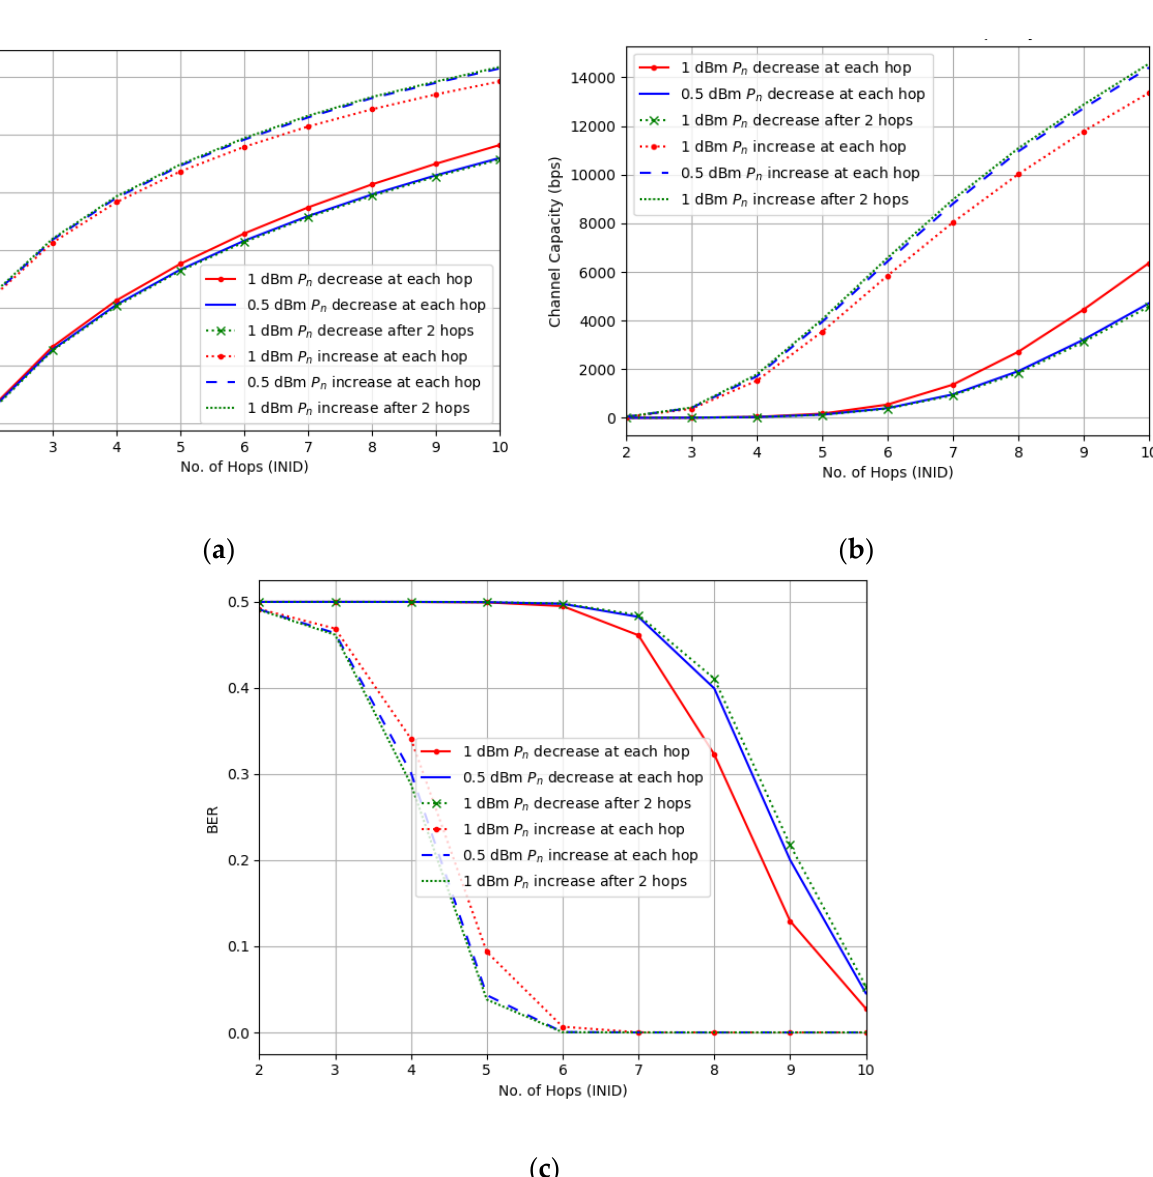
Figure 10. Multihop underground MI communication system’s performance for INID of channel states between hops. Decreasing noise scenarios across hops were considered for high noise power ( 𝑃 𝑛 = − 83 dBm) at hop 1, and increasing noise scenarios across hops were considered for low noise power ( 𝑃 𝑛 = − 103 dBm) at hop 1. The panels show the variation of the ( a ) SNR (dB), ( b ) channel capacity (bps) and ( c ) BER with the noise power across hops.